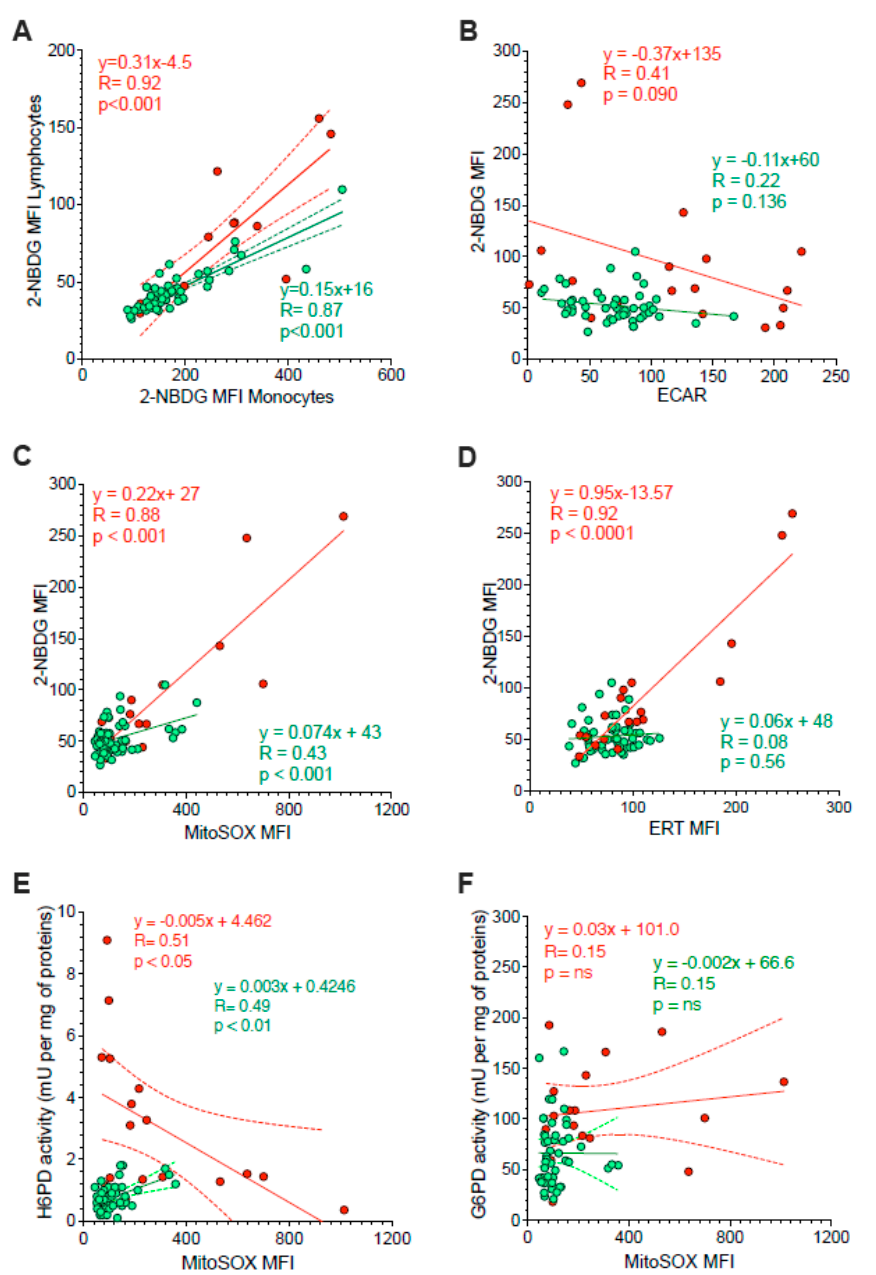
Figure 5. Correlation between ER function and glycolysis or mitochondria redox stress. Panel ( A ) displays the correlation between 2-NBDG MFI of monocytes (x-axis) and lymphocytes (y-axis) sampled from controls (green) and HL patients (red). Simple linear regression (continuous line) and 95% confidence bands of the best-fit line (dashed line) of controls (green) and HL patients (red). Shifting to the analysis of the whole PBMC population, panel ( B ) displays the absent proportionality between 2-NBDG and extracellular acidification rate (ECAR). By contrast, panel ( C ) reports the direct relation between 2-NBDG and MitoSOX fluorescence. The role of ER in 2-NBDG uptake is confirmed in panel ( D ) by the direct correlations between the fluorescence of this glucose analogue and that of the ERTracker glibenclamide (ERT). The relevance of ER-PPP in the response to the increase in mitochondrial ROS generation is indicated by the inverse correlation between MitoSOX fluorescence ( x -axis) and H6PD activity ( y -axis) reported in panel ( E ). This same correlation did not involve G6PD activity ( F ). Continuous lines represent the identified function while dashed lines represent the 95% confidence bands of the best-fit in both controls (green) and HL patients